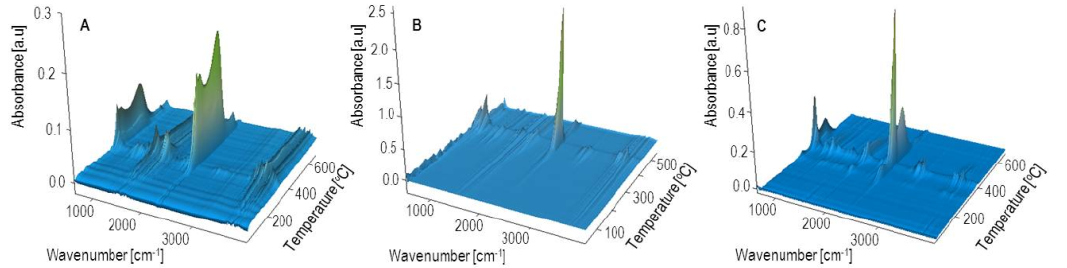
Figure 15. Three dimensional FTIR diagrams of gaseous decomposition products of bran ( A ) PBS ( B ) and biocomposite